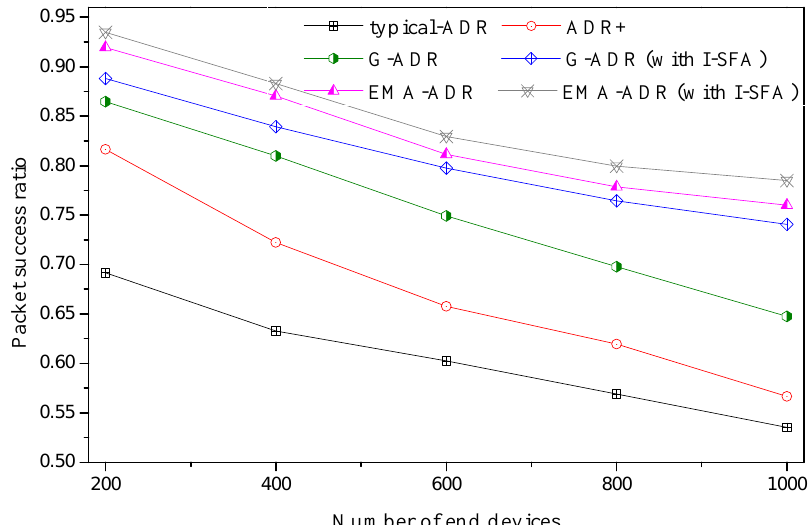
Figure 10. Average PSR of static EDs (uplink period = 24 packets/day, total simulation time = 4 days).